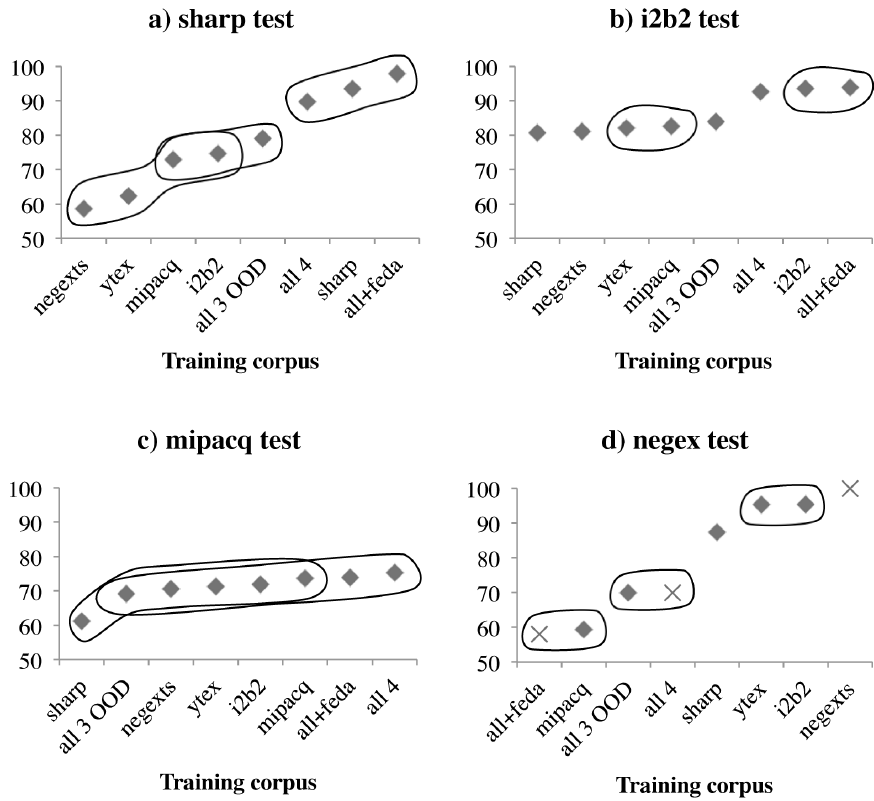
Figure 2. Significance bands of model performance for each test corpus. These are labeled with successive letters from right to left in Table 4.